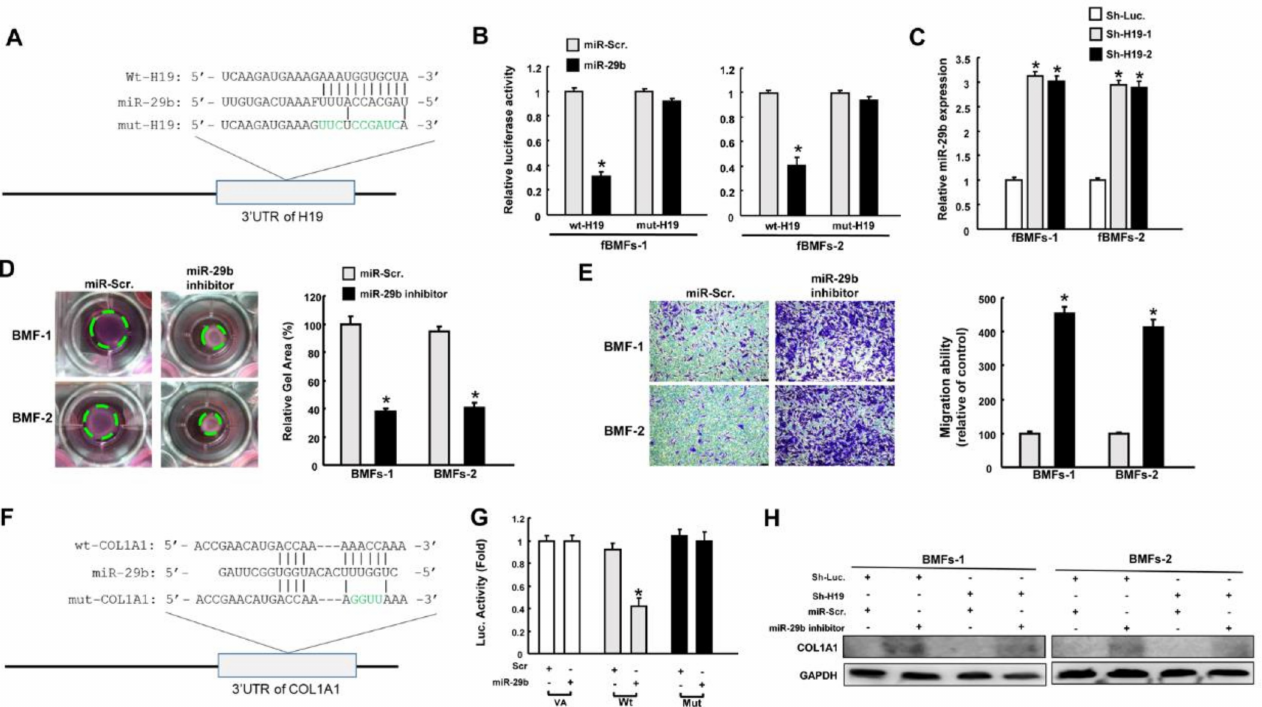
Figure 3. Repression of miR - 29b by H19 results in upregulation of type I collagen. ( A ) Schematic of miR - 29b and the putative binding sequence, as well as the mutant sequence at the 3’-untranslated region (3 (cid:48) UTR) of H19 . ( B ) Luciferase activity decreased when fBMFs were cotransfected with Wt - H19 and miR - 29b mimics. ( C ) Relative expression of miR - 29b in H19 -silenced fBMFs. Collagen gel contraction ( D ) and migration ability ( E ) of BMFs with miR - 29b inhibitor or miR-Scr (scramble). Magnification, 100 × ( F ) Schematic of miR - 29b and the putative binding sequence in the 3 (cid:48) UTR sequence of Wt-COL1A1 and mutant sequence. ( G ) Luciferase activity was decreased when fBMFs were cotransfected with Wt-COL1A1 and miR - 29b mimics. ( H ) Protein expression of type I collagen in BMFs with or without sh-Luc, sh - H19 , miR-Scr, and miR - 29b inhibitor. * p < 0.05 compared to